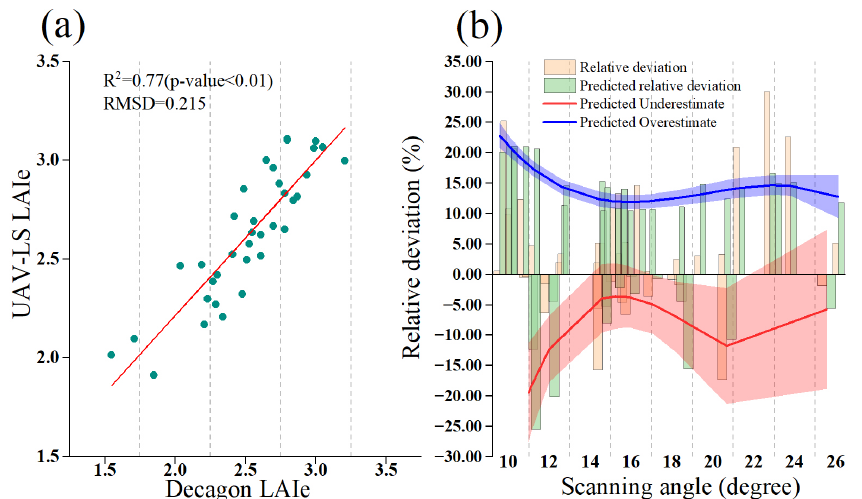
Figure 15. ( a ) UAV-LS LAIe versus Decagon LAIe; ( b ) relative underestimation and overestimation between UAV-LS LAIe and Decagon LAIe predicted considering angular effects.